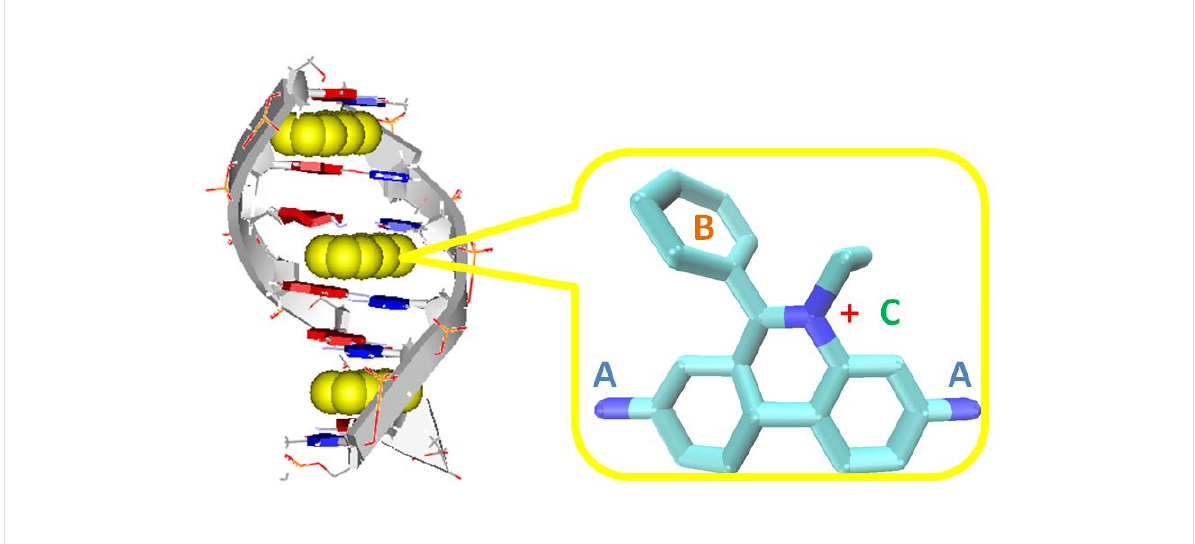
Figure 1: Schematic presentation of the intercalative binding mode by the neighbour exclusion principle and important structural features of ethidium bromide: A ) amino substituents responsible for fluorescence increase upon DNA intercalation; B) phenyl substituent for steric control and also impact on fluorimetric properties; C) permanent positive charge for aqueous solubility and electrostatic attraction to the DNA or RNA phosphate